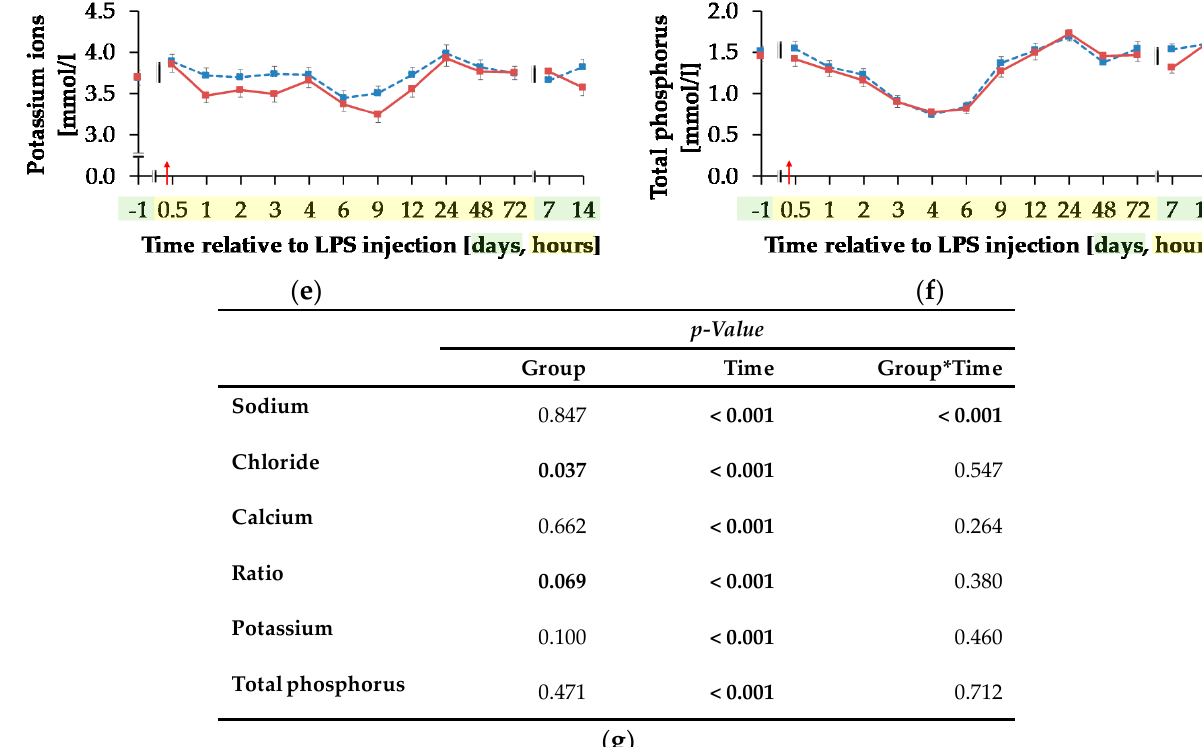
Figure 9. Progression of different electrolytes and total phosphorus in blood of dairy cows fed a non-supplemented (CON) or an L-carnitine supplemented diet (CAR, 25 g/d from 6 weeks ap up to day 126 pp) before and after an intravenous injection of 0.5 μ g/kg BW lipopolysaccharides (LPS) on day 111 pp (red arrow). ( a ) Concentration of sodium ions and ( b ) chloride ions, ( c ) calcium ions and ( d ) the ratio of calcium ions to total calcium, ( e ) potassium ions and ( f ) total phosphorus in whole blood. ( g ) Data statistics. Data are given as LS-Means standard errors Significant p -values are marked as bold.